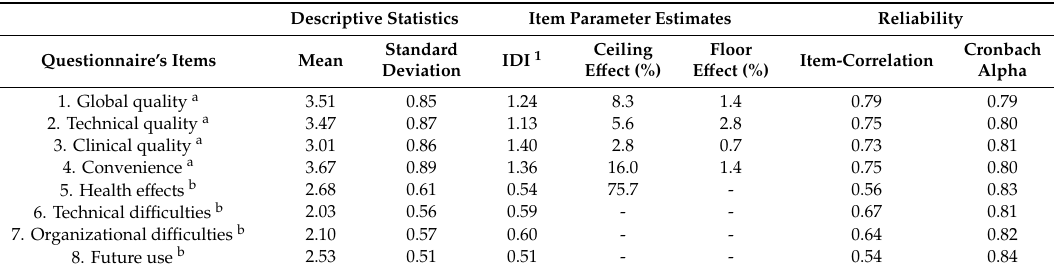
Table 1. Psychometric